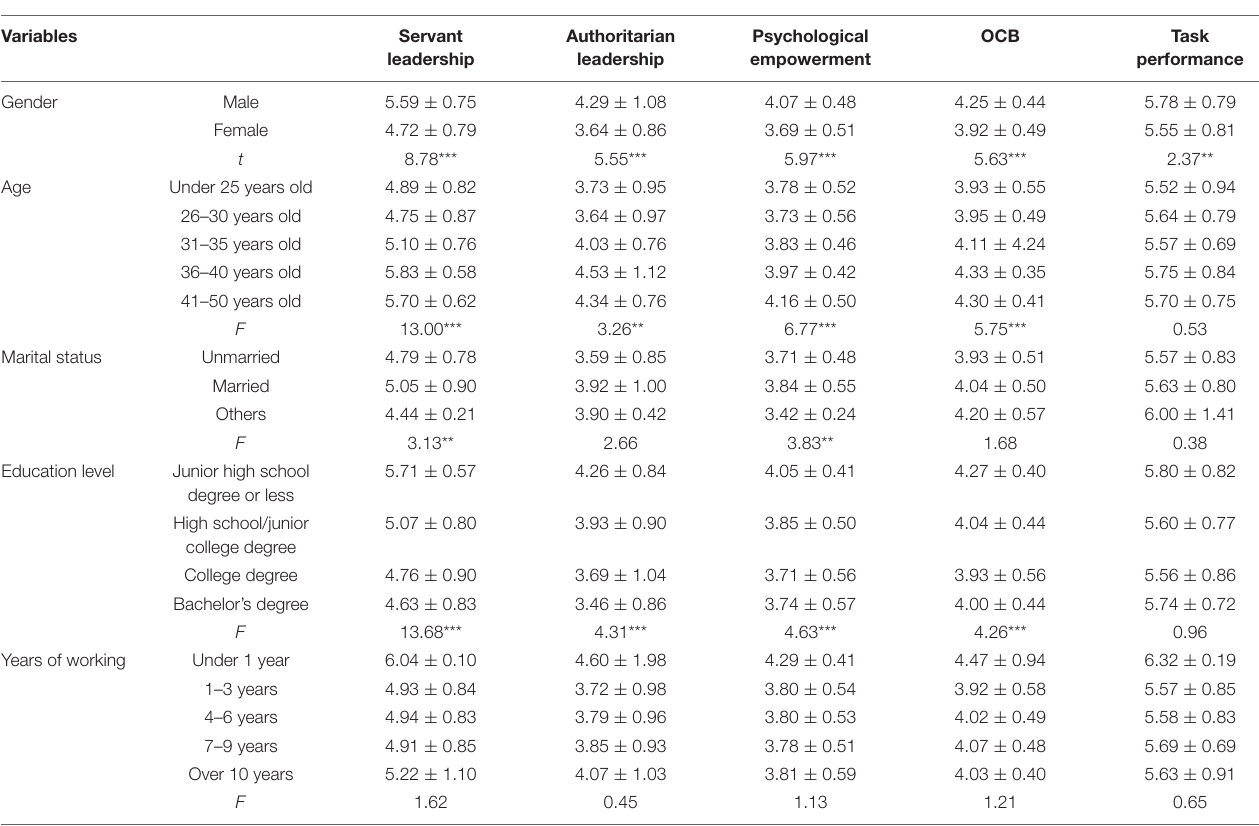
TABLE 3 | Difference tests for the control